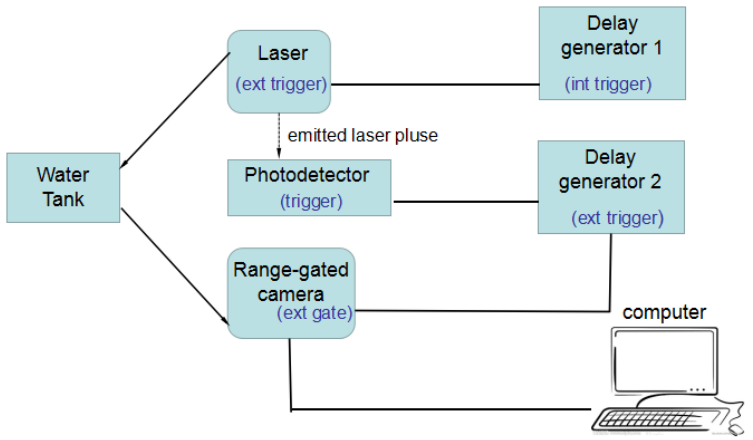
Figure 2. Synchronization control of the gated wavefront system.